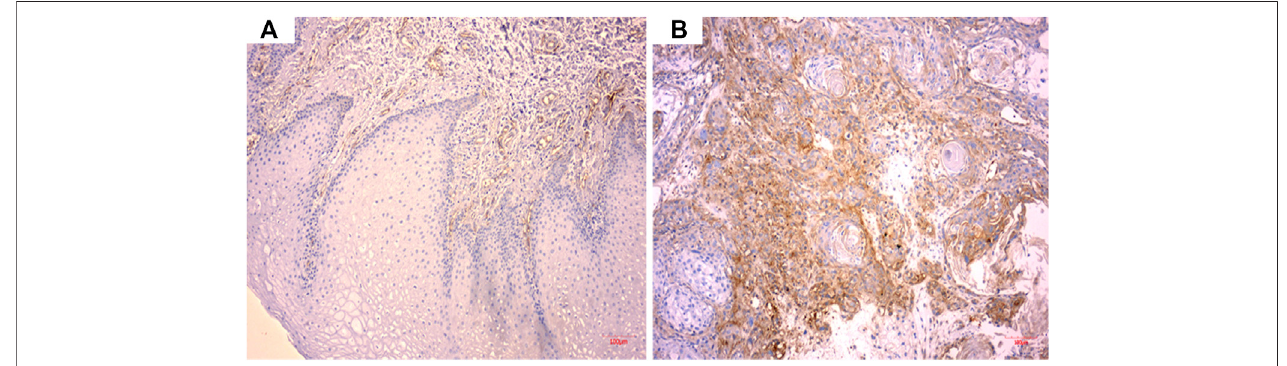
FIGURE 1 | CD59 expression in oral squamous cancer cells. (A) Low expression of CD59 in normal oral keratinocytes. (B) High expression of CD59 in oral squamous carcinoma cells.